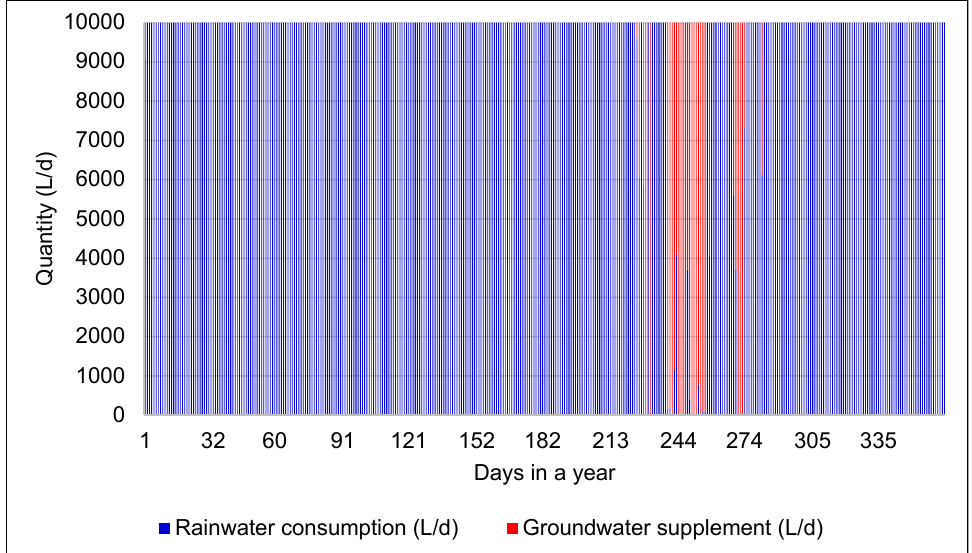
Figure 6. Daily rainwater consumption and required supplement to meet at demand of 10 L/person/d at NM ‐ AIST with a target maximum population of 1000 people.